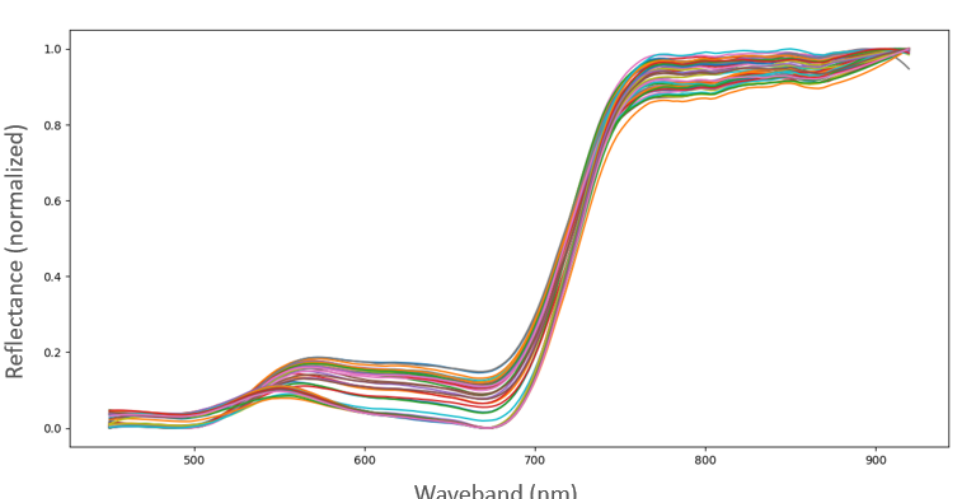
Figure 3. Plot of the hyperspectral signatures spanning an area of the leaf containing healthy wheat tissue, rust disease, and the transition zone between the two. Spectral signatures are shown after preprocessing (cutting noisy bands, Savitzky– Golay smoothing and normalization). Each curve represents the spectral signature of a pixel in the cross section of the area, with pixels ranging from healthy to fully diseased.